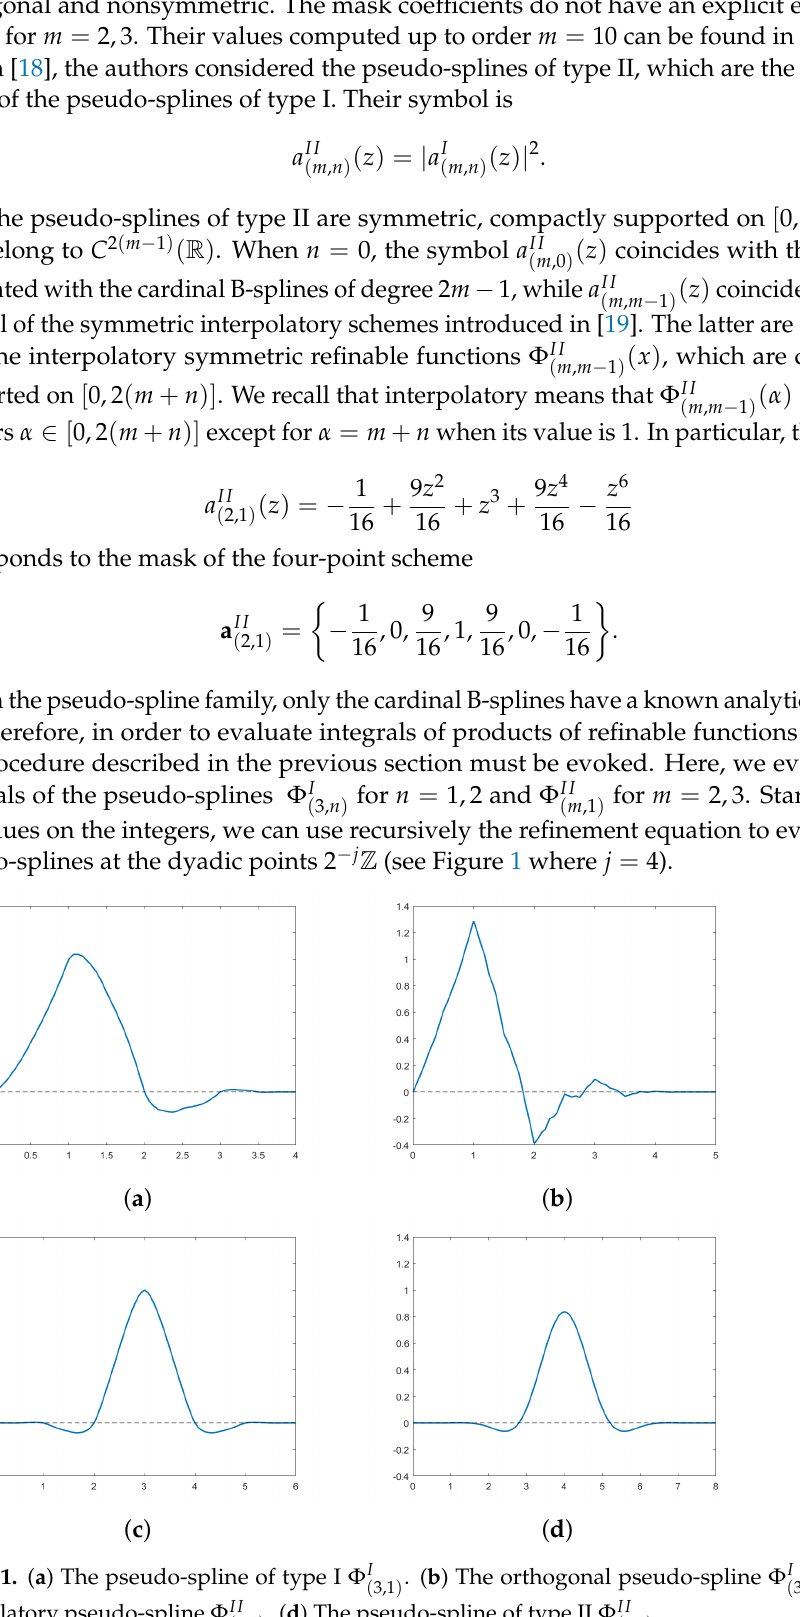
. ( b ) The orthogonal pseudo-spline Φ I ( 3,1 ) . ( d ) The pseudo-spline of type II Φ II ( 2,1 )